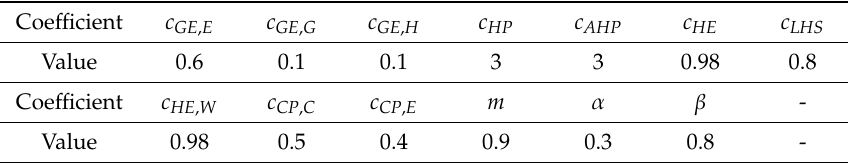
Table 1. E ffi ciency of all energy conversion